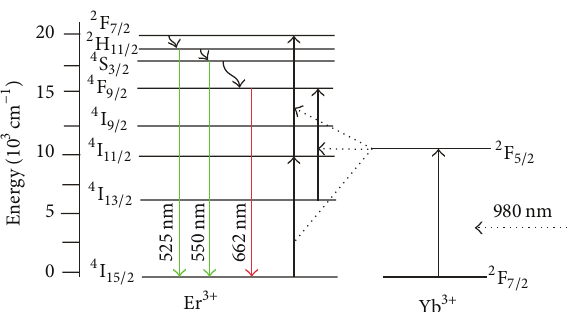
Figure 8: Energy level diagram of Er 3+ and Yb 3+ ions illustrating possible upconversion pathways for Er 3+ /Yb 3+ codoped glasses. The solid straight lines with upward and down arrows indicate optical transitions; dotted lines and wavy arrows denote ET processes and non-radiative relaxation, respectively